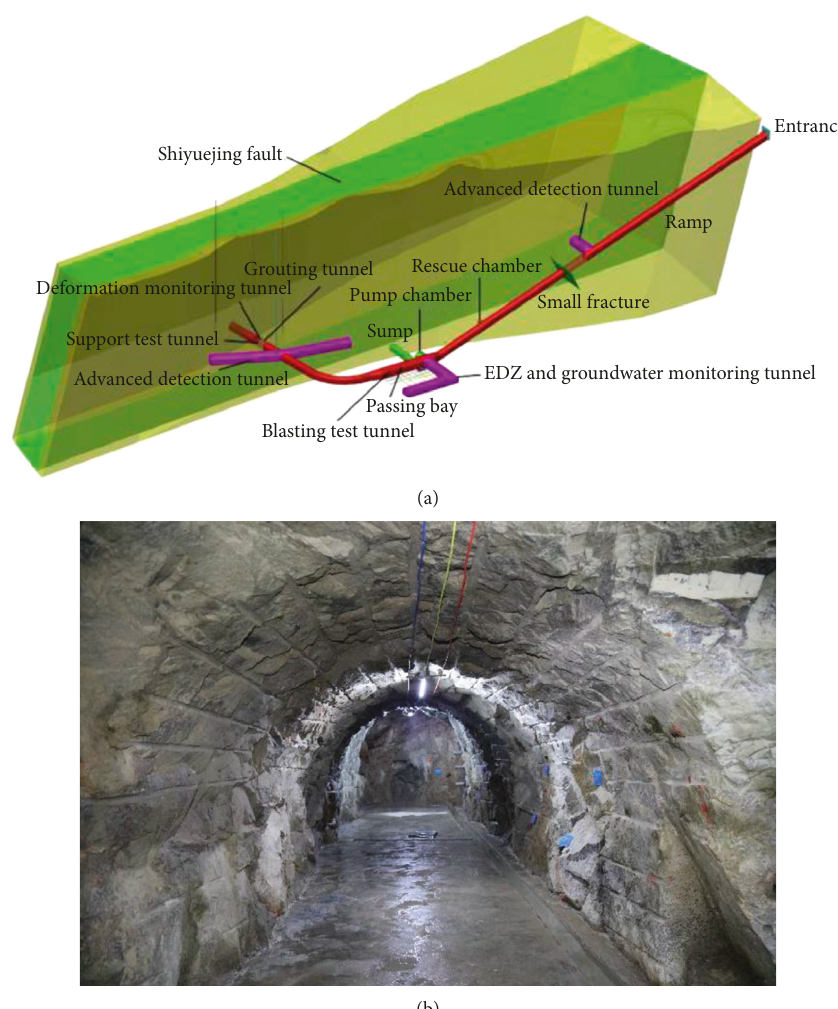
Figure 2: Site for blasting